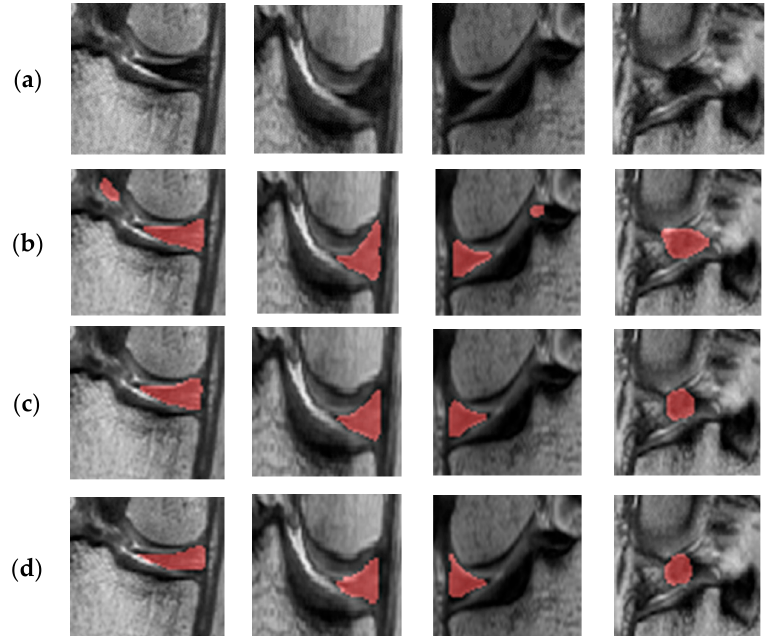
Figure 6. Segmentation results of conventional adversarial network and adversarial network using an object ‐ aware map: ( a ) Original image; ( b ) Conventional adversarial network; ( c ) Adversarial network using object ‐ aware map; ( d ) Ground truth.